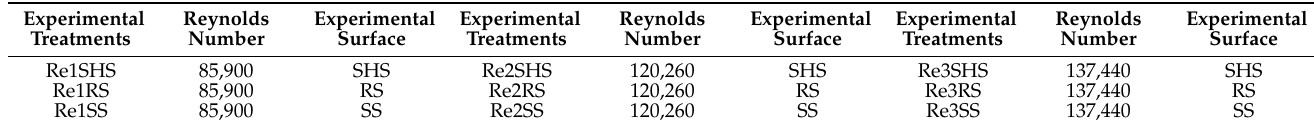
Table 1. Experimental